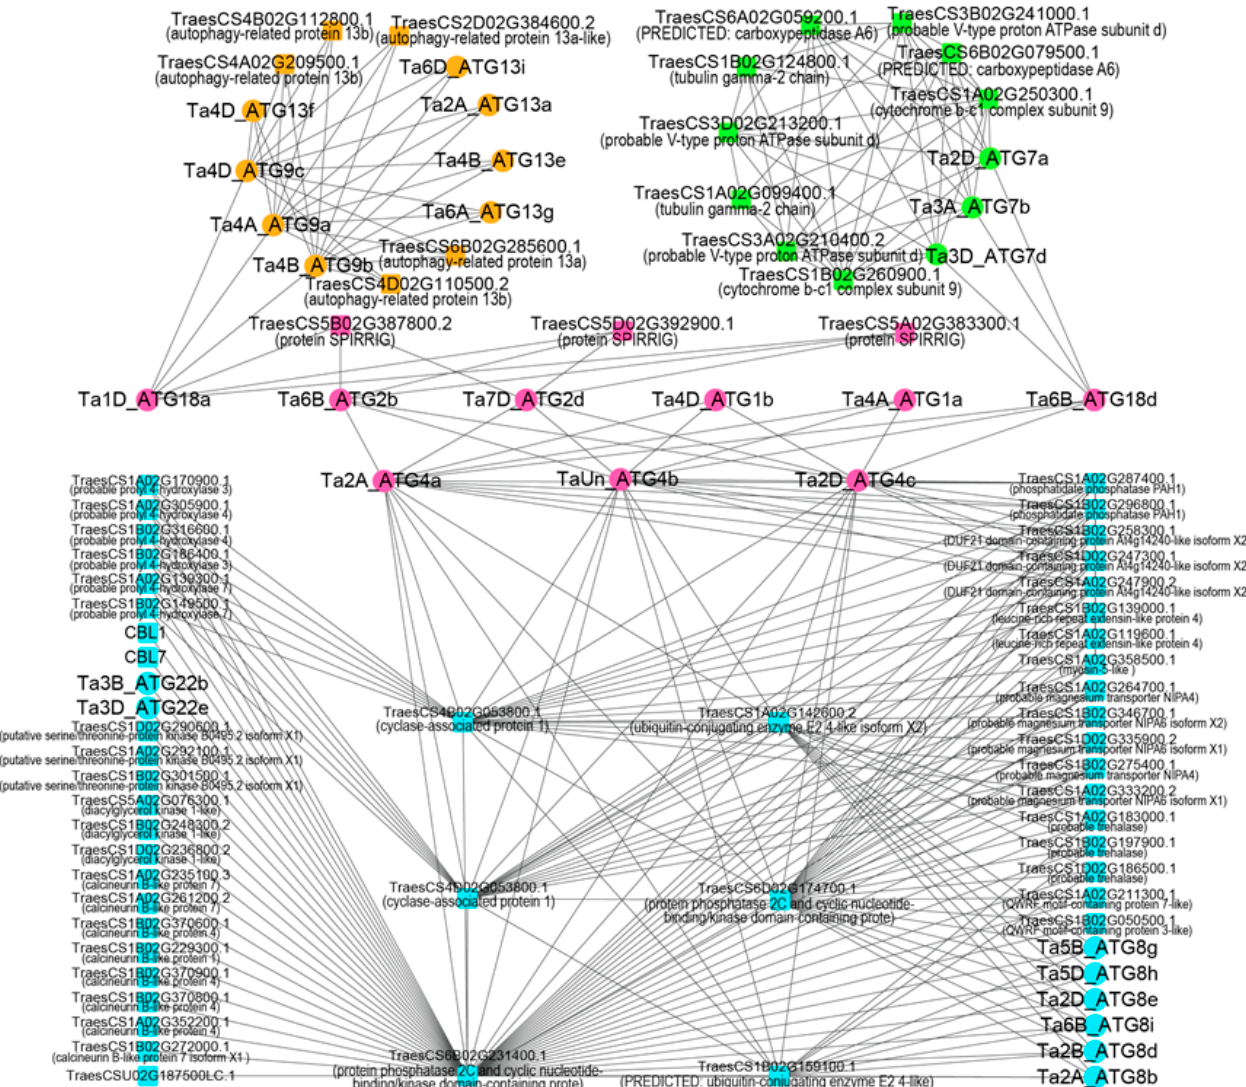
Figure 3. Protein-protein association networks of ATGs. The identified ATGs were submitted to the STRING database to construct the protein-protein interaction networks based on the Triticum aestivum dataset. The network could be clustered into four parts and represented in different colors. The circles are the ATGs identified in this study, and the squares represent the co-expressed proteins found in the database.